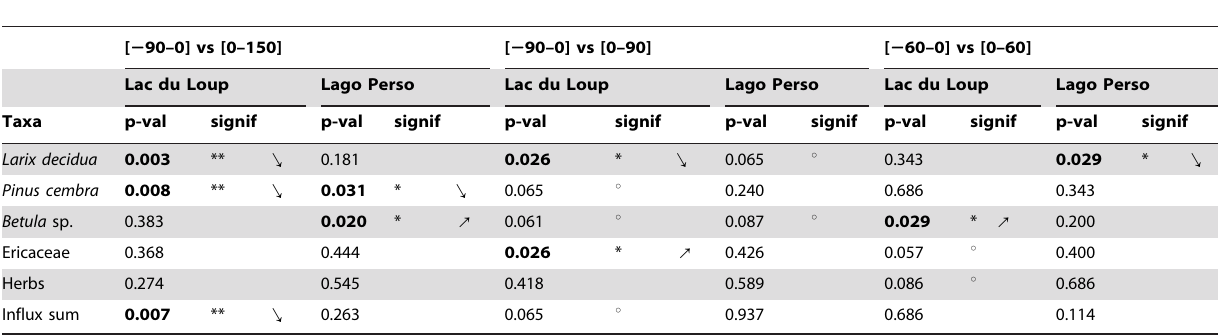
Table 1. Differences between pre- and post-fire abundance of macroremains SEA mean influx following fire events for different time